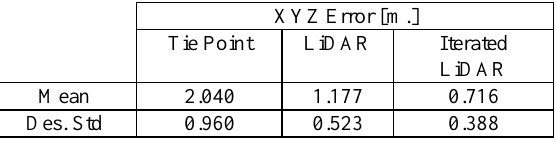
Table 6: 2008 Check Points error values 4.1.2.3. 2001 Flight: The Figure 14 show the evolution of the